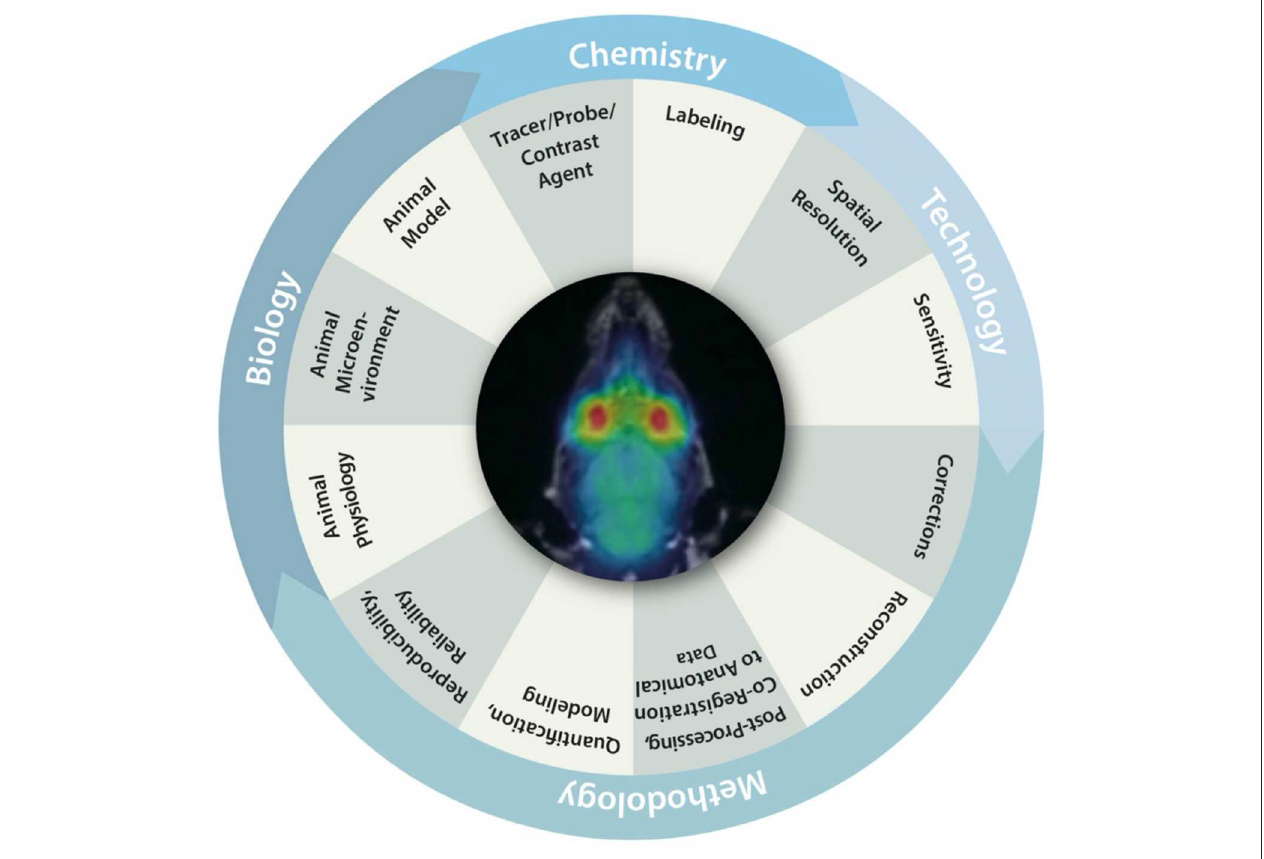
FIGURE 7 | Biological, chemical, methodological and technical factors inherently linked to the reproducibility, reliability and comparability of preclinical imaging data. Figure adapted from Figure 1 from Herfert et al. [118] with reprint permission from Springer according to their creative common license http://creativecommons.org/